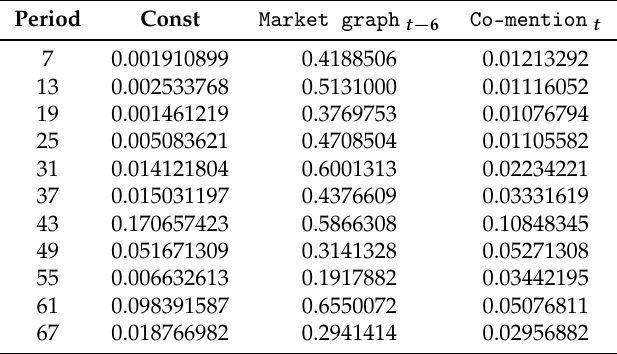
Table 6. The results of the QAP regression